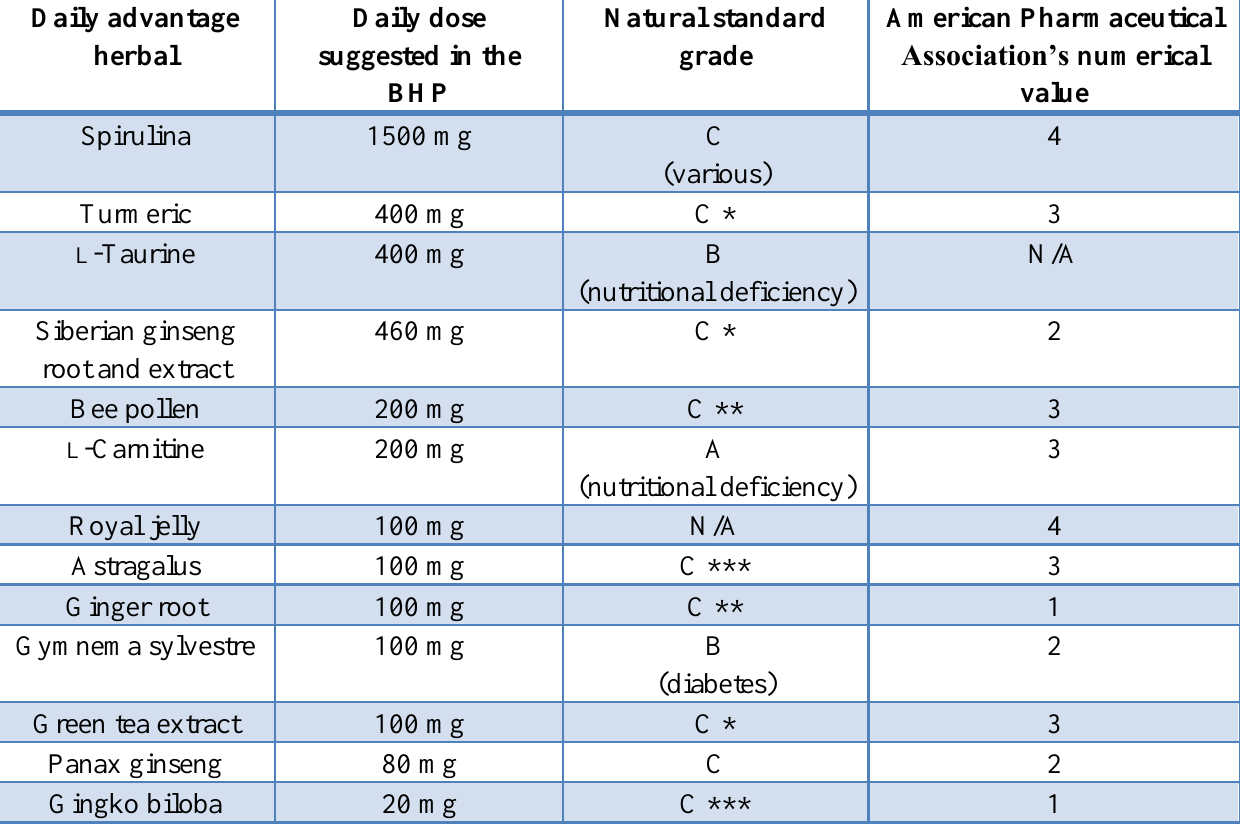
Table 3. Daily advantage superfood herbal